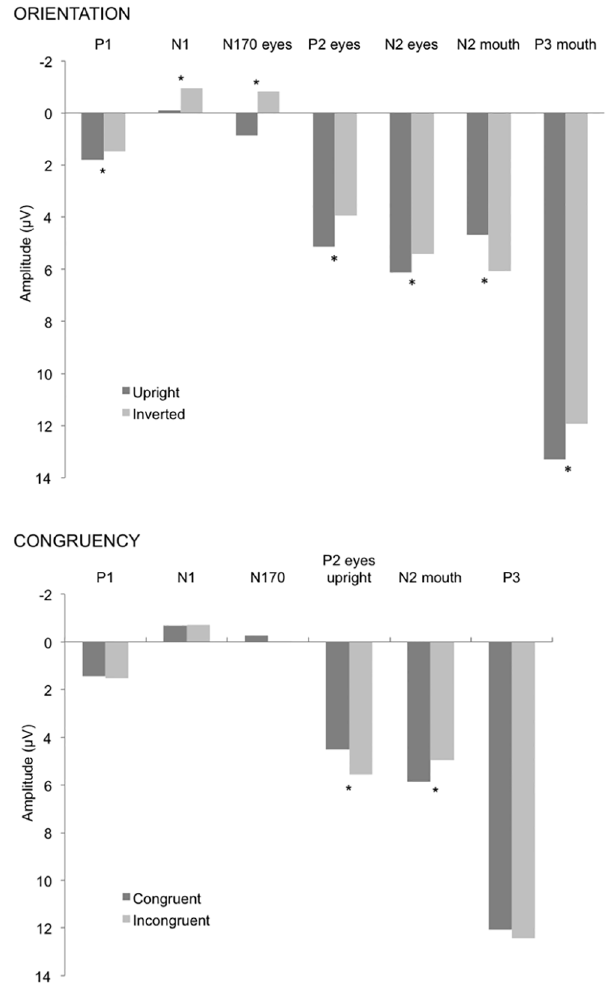
Fig 4. Time course of implicit face processing. Histogram of the amplitude of face-sensitive ERP components as a function of internal features and face orientation (upper panel) and as a function of internal features and prime-target congruency (lower panel). * p <